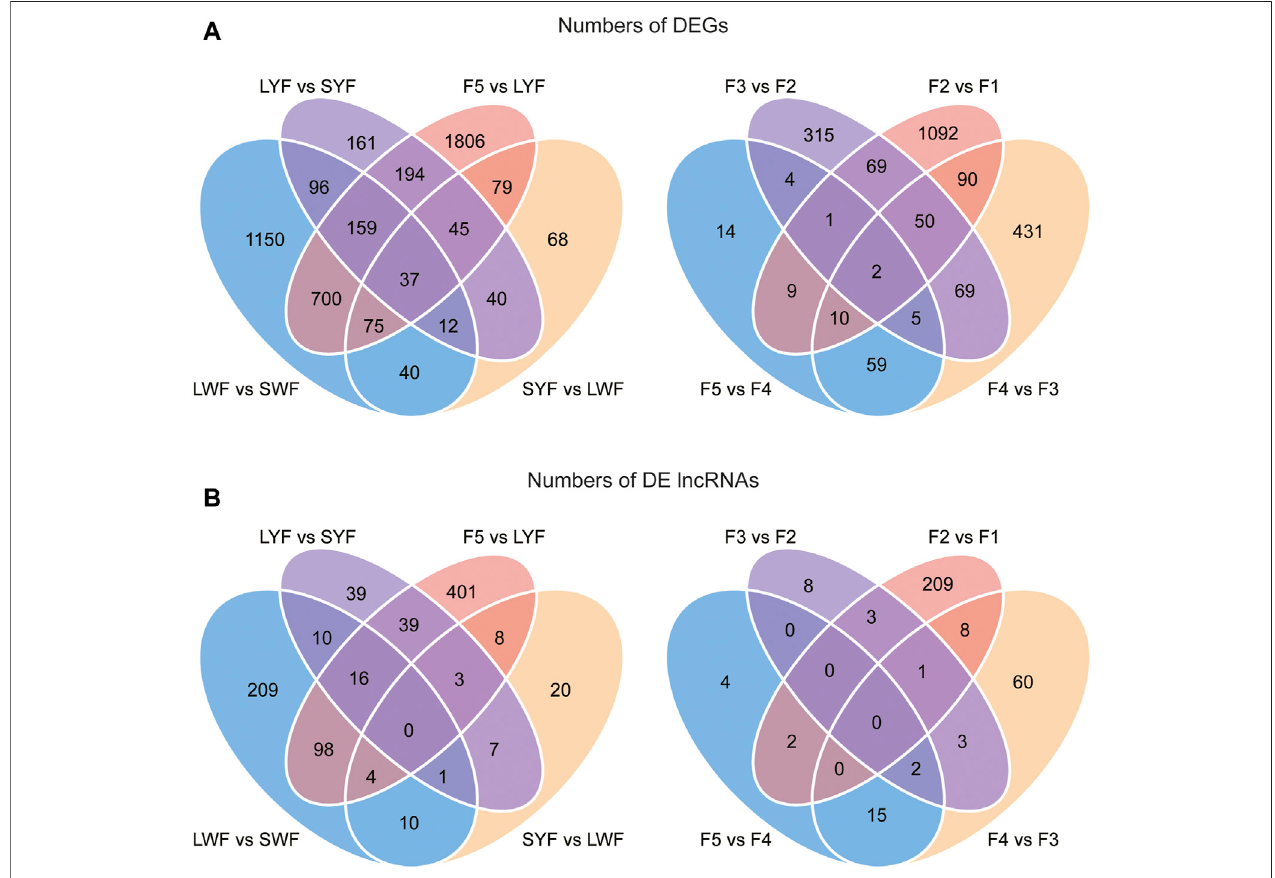
FIGURE 3 | The common DEGs and DElncRNAs detected by comparing the adjacent pairs of developmental stages. Note (A) : The common DEGs in the pre- hierarchical follicles and hierarchical follicle GCs; (B) : The common DElncRNAs in the pre-hierarchical follicles and hierarchical follicle GCs.